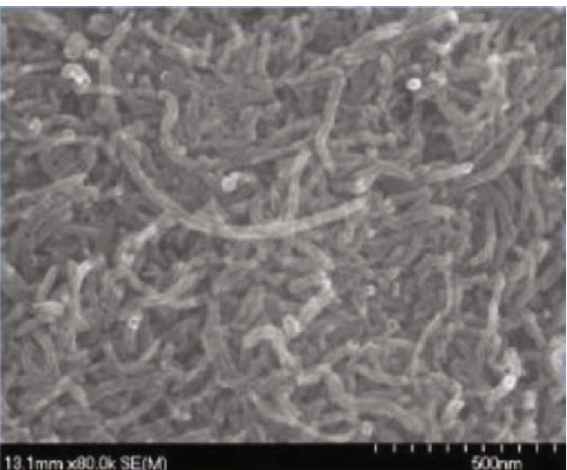
Figure 1: SEM image of